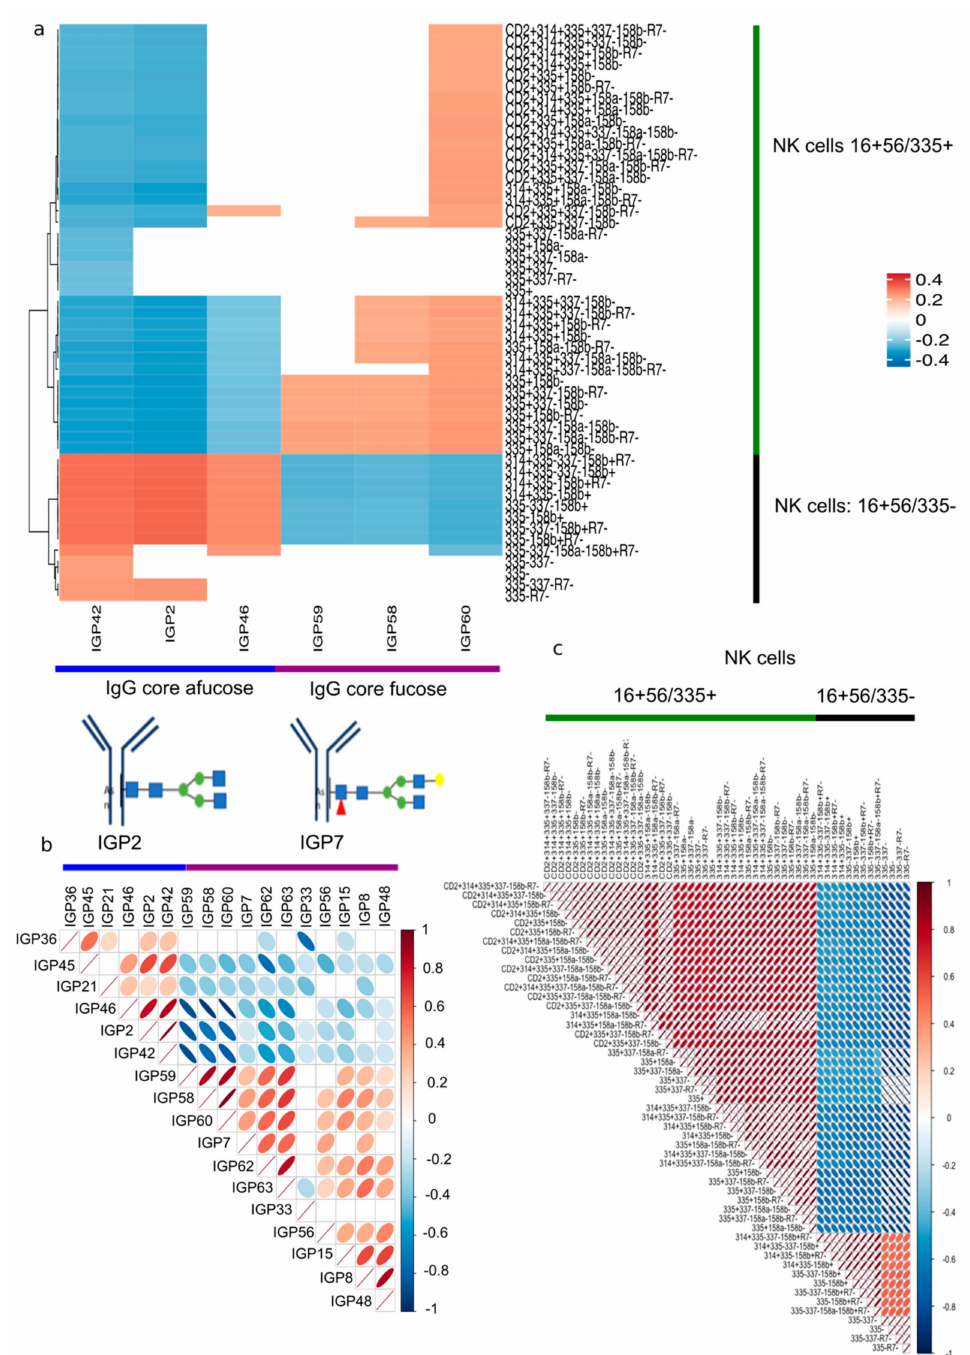
Figure 2. AITD-IgG N-glycan traits associated with a subpopulation of NK cells. ( a ) Heatmap of immune cell traits associated with AITD-IgG N-glycan traits. The 51 NK cell types were significantly associated with six out of 17 AITD-IgG N-glycan traits previously identified [4]. Below the heatmap, there are one representative of IgG core afucose (IGP2) and one representative of IgG core fucose (IGP7), that were both associated with AITD and TPOAb levels [4]. ( b ) Co-expressions between only 17 IgG N-glycan traits previously associated significantly with AITD status and TPOAb level [4]. ( c ) Correlations between the profile of 51 immune cell traits that were associated significantly with at least one of 17 AITD-IgG N-glycan traits. The order of immune cell traits is the same as that in Figure